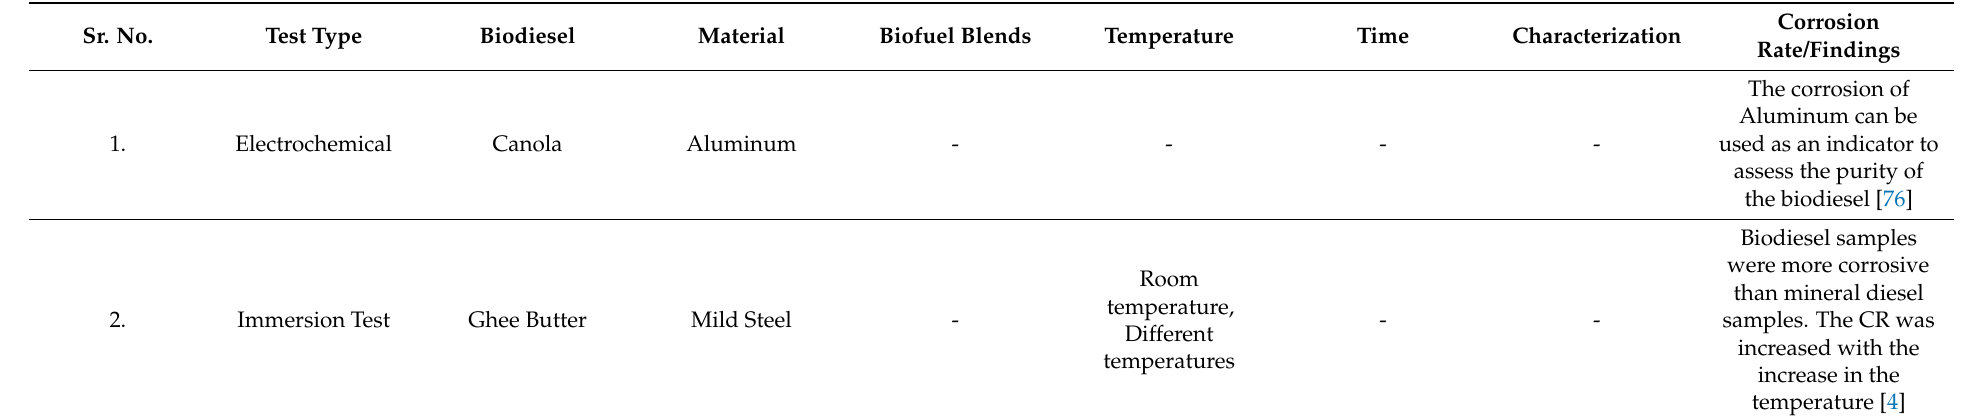
Table 5. Summary of corrosion studies on biodiesel of different feedstock.